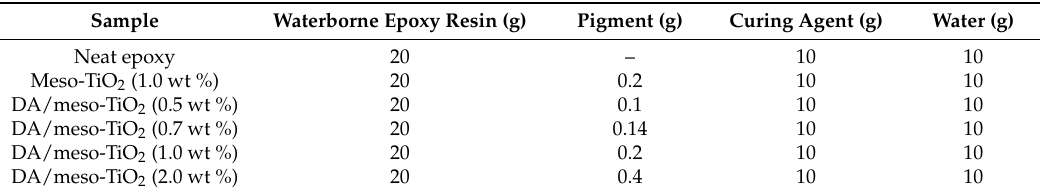
Table 1. Formulation of